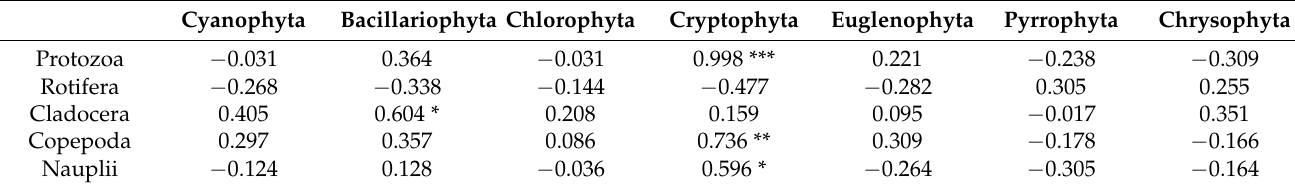
Table 2. Correlation coefficient of Pearson correlation of phytoplankton and zooplankton